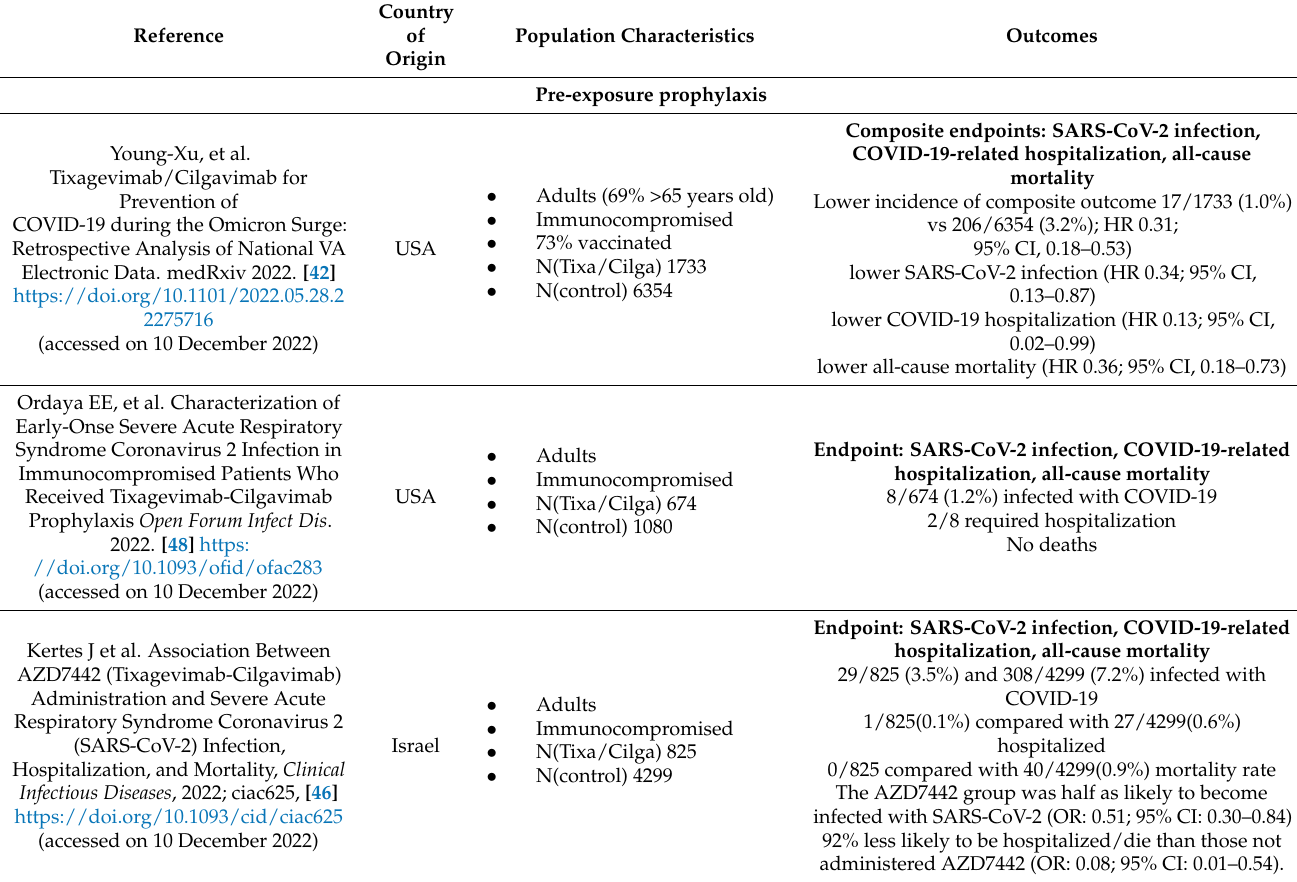
Table 2. Real-world evidence on the effectiveness of Tixagevimab/Cilgavimab in terms of pre- exposure